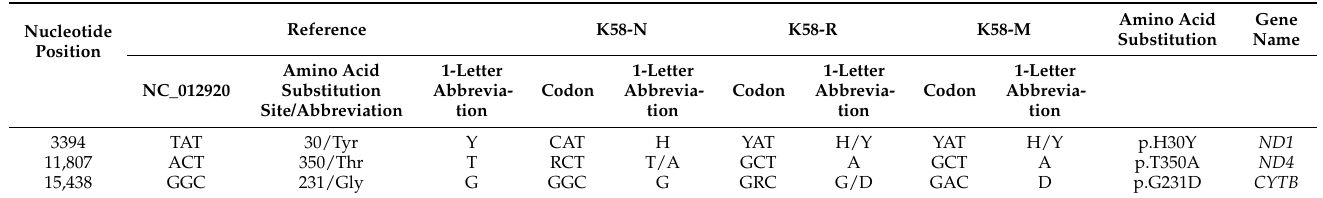
Table 3. Amino acid substitution sites from the three sequenced